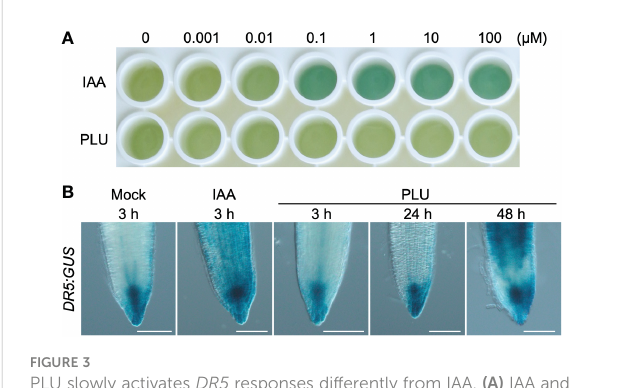
FIGURE 3 PLU slowly activates DR5 responses differently from IAA. (A) IAA and PLU at various concentrations were applied to the yeast two-hybrid assay that shows the TIR1-AUX/IAA interaction by blue color. (B) 5-dpi DR5:GUS seedlings were treated with DMSO (mock), 0.5 µM IAA, or 40 µM PLU. GUS staining was performed at indicated time points after compound treatment. Scale bars: 100 m